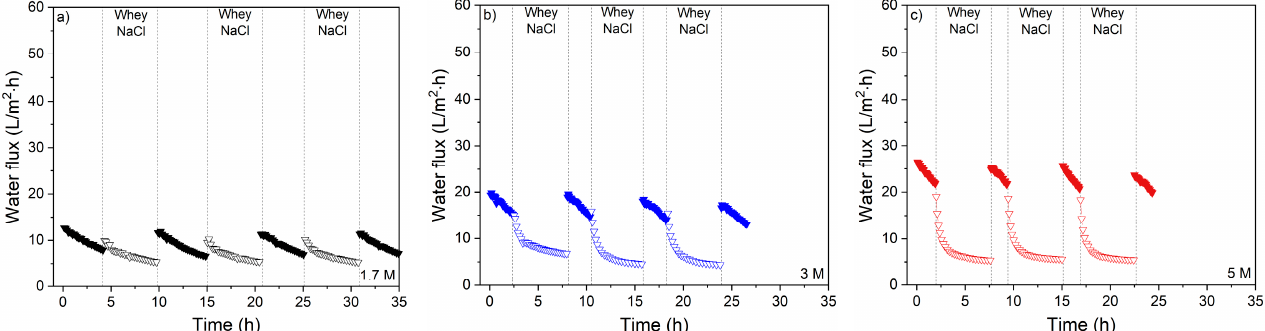
Figure 10. Water flux of the membranes in longer periods of salty whey filtration (three times, in total ~17 h) with interme-